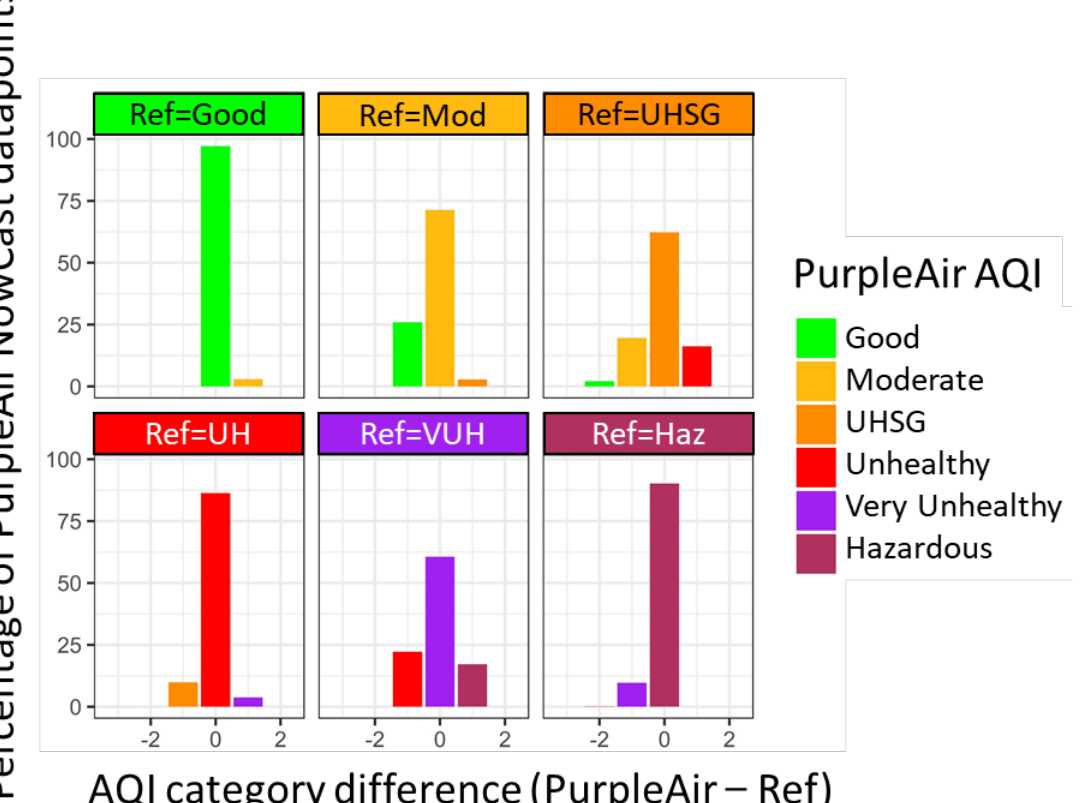
Figure 3. Percentage of the time that the PurpleAir NowCast AQI is the same as or different by 1 or 2 NowCast AQI categories. This is binned by the reference NowCast AQI category. It includes data using both withholding methods.